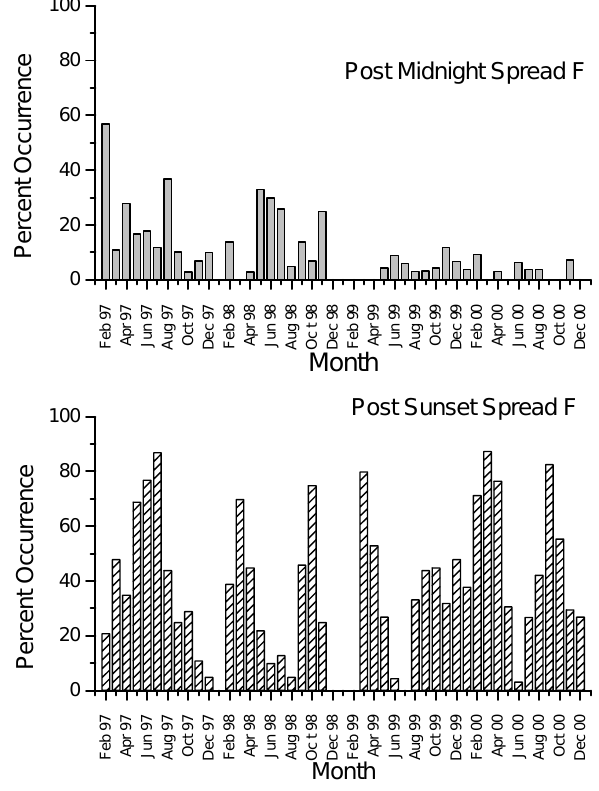
Fig. 1. Histogram showing the monthly percent occurrence of post midnight spread-F (top panel) and post sunset spread-F (bottom panel) at Waltair during